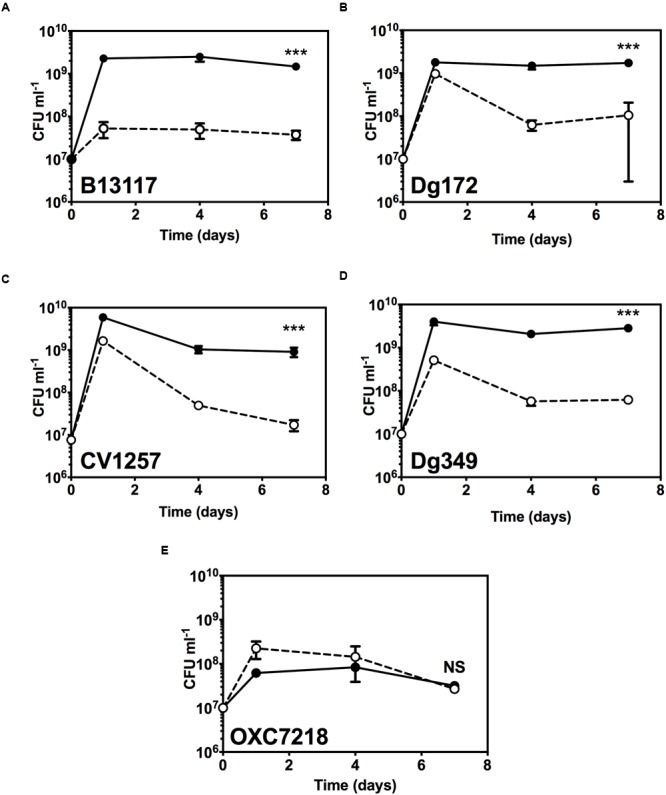
Extended stationary phase survival with glucose. Viable cell numbers of ED-positive C. coli isolates (B13117, CV1257, Dg172, and Dg349) and an ED-negative control C. coli strain (OXC7218) were determined in TSB with or without supplementation with 100 mM glucose. Cultures were incubated for 7 days at 37°C in microaerobic conditions and the viability determined by enumerating CFU at various time intervals. Results are mean and standard deviations of three independent cultures. The error bars are too small to be seen in some cases. (A)
C. coli B13117; (B)
C. coli CV1257; (C)
C. coli Dg172; (D)
C. coli Dg349; (E)
C. coli OXC7218 (ED-negative control). Open circles and dashed line, cell numbers without glucose; filled circles and solid line, cell numbers with glucose. The statistical significance of the difference between the control without glucose and with added glucose at 7 days was tested by Student’s t-test, as indicated by (∗∗∗p < 0.001) or NS (not significant).